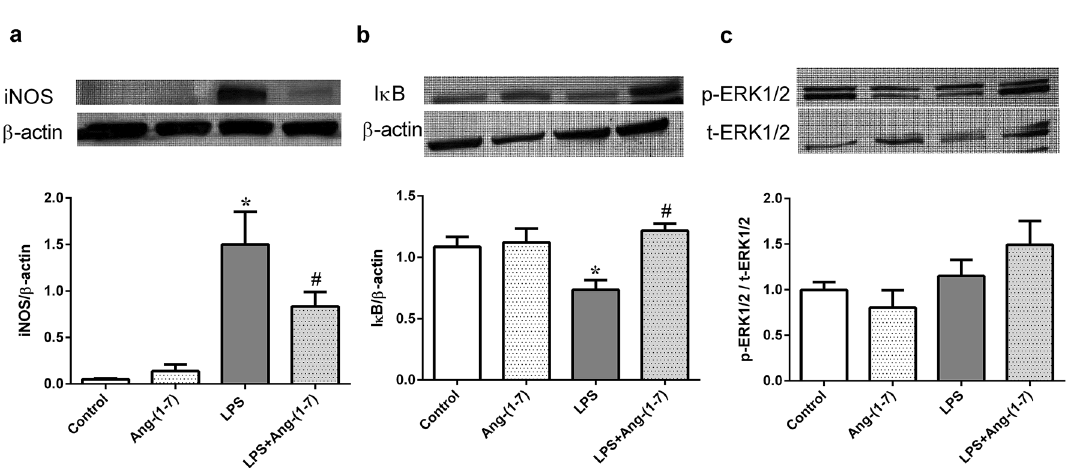
Figure 7. Ang-(1–7) attenuates the increased expression of inducible nitric oxide synthase and IκB, but not extracellular signal-regulated kinase 1/2, in endotoxaemic rats. We assessed the changes in inducible nitric oxide synthase (iNOS) ( a ), cytoplasmic IκB ( b ), and extracellular signal-regulated kinase (ERK) 1/2 ( c ) in the liver tissues of rats infused with 0.9% NaCl (control), angiotensin (Ang)-(1–7) (1 mg/kg for 3 h), E. coli lipopolysaccharide (LPS, 10 mg/kg for 15 min), or LPS plus Ang-(1–7) (1 mg/kg for 3 h at 0.5 h after LPS). Liver tissues were harvested 24 h after LPS administration. Representative blots are shown in the upper panel of the figure. β-actin and total ERK1/2 served as loading controls for iNOS and IκB and for phosphorylated ERK1/2, respectively. The data are shown as the mean ± standard error of the mean from 4 rats per group. *, p < 0.05 for LPS vs. control. # , p < 0.05 for LPS + Ang-(1–7) vs.